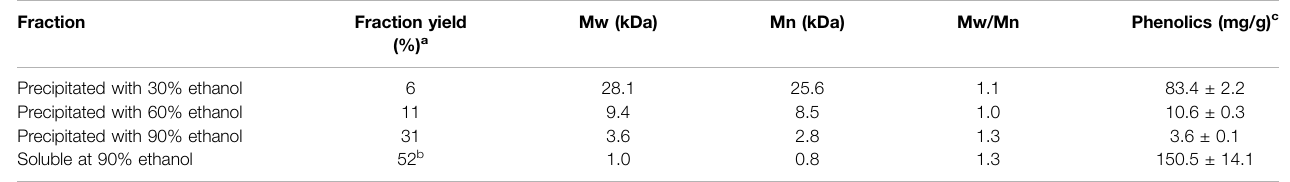
TABLE 2 | Fractionation yield and molar mass distribution of enzymatically extracted glucuronoarabinoxylan (GAX) from alkaline-sul fi te – pretreated sugarcane bagasse after precipitation by increasing ethanol concentrations. Mw (kDa) Mn Fraction Fraction yield (%) a